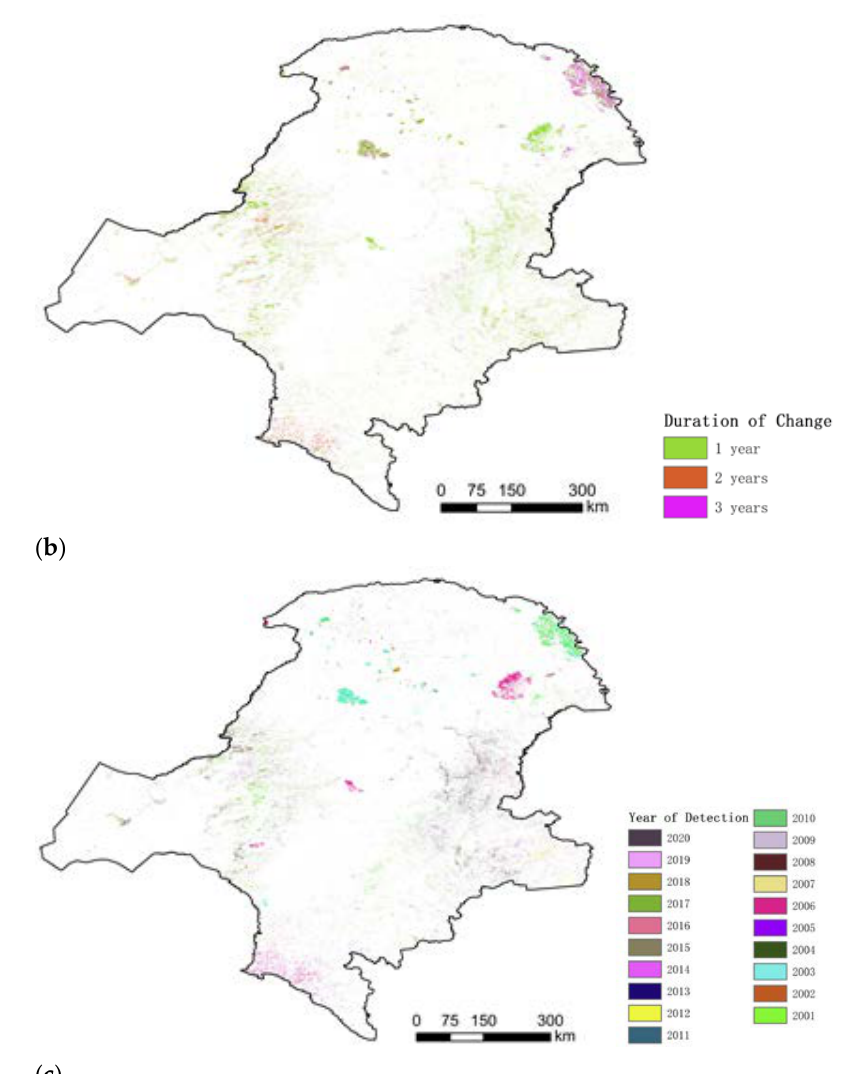
Figure 10. Forest disturbance and recovery at multi-scale and time series in Great Khingan Mountain (GKM), China: ( a ) magnitude of change, ( b ) duration of change, and ( c ) year of detection.